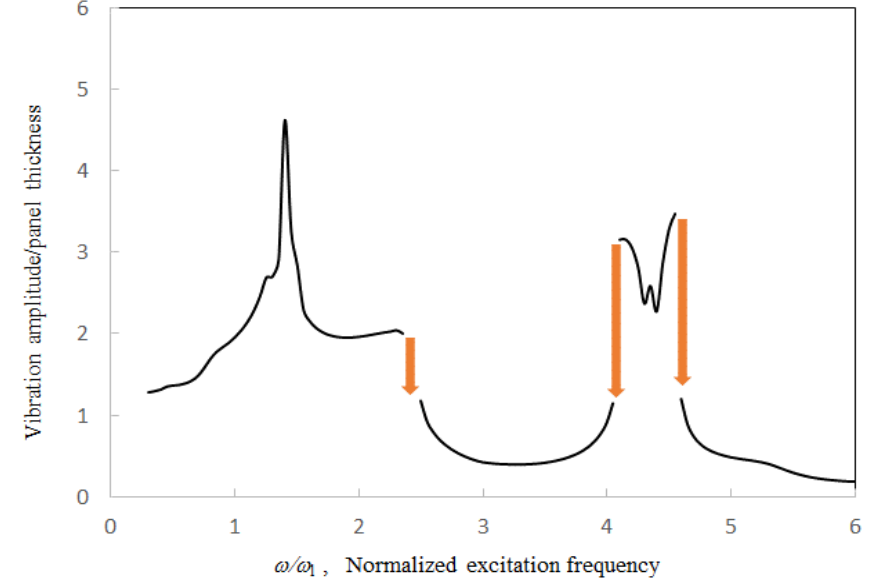
Figure 11. Vibration amplitude ratio versus normalized excitation frequency for various acoustic boundary conditions (number of structural modes = 2, number of acoustic modes = 4, γ = 2, θ = 0, l = 5 a ; the orange arrows represent the “jump phenomenon”).